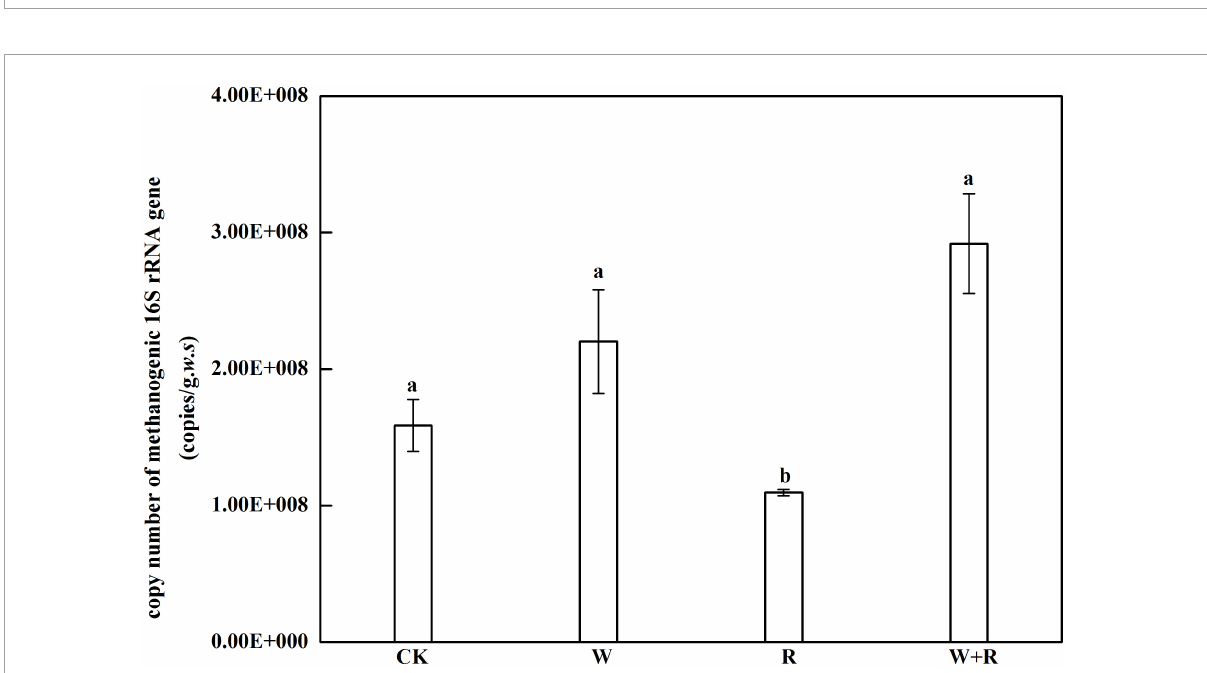
FIGURE5 Abundance of methanogens is represented by 16S rRNA genes. Data points show the mean and standard error. Lowercase letters indicate a significant difference at P <